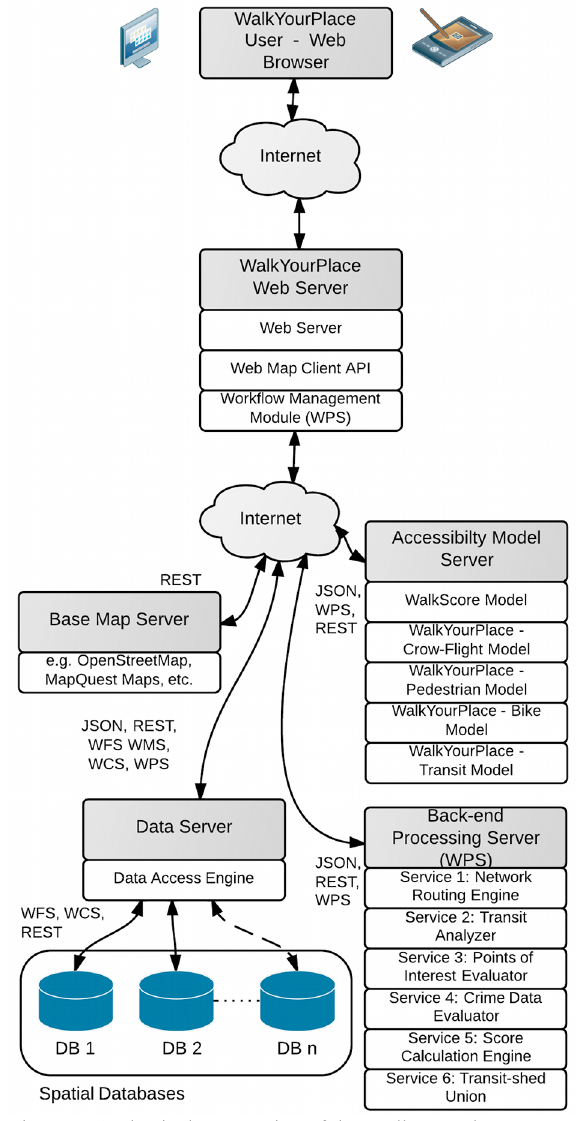
Figure 1: A physical perspective of the WalkYourPlace